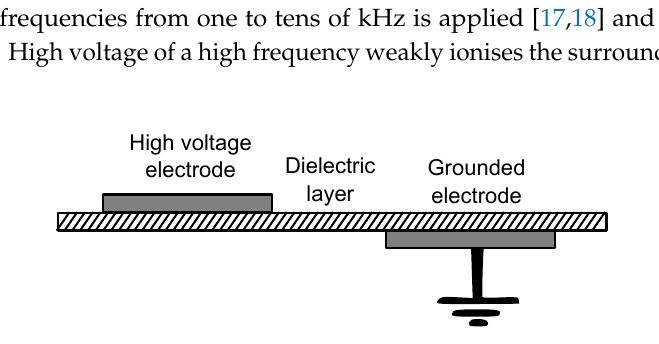
Figure 2. Schematic view of a dielectric barrier discharge plasma